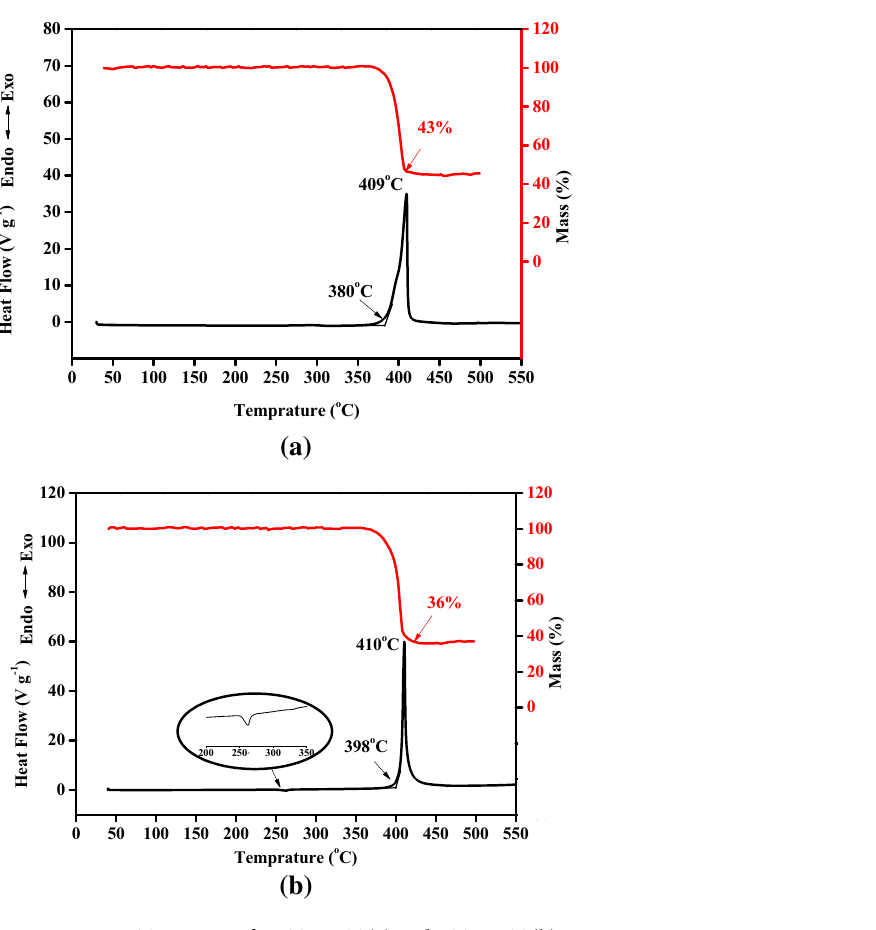
Figure 5. DSC-TG curves of y-PTACOT ( a ) and z-TACOT ( b